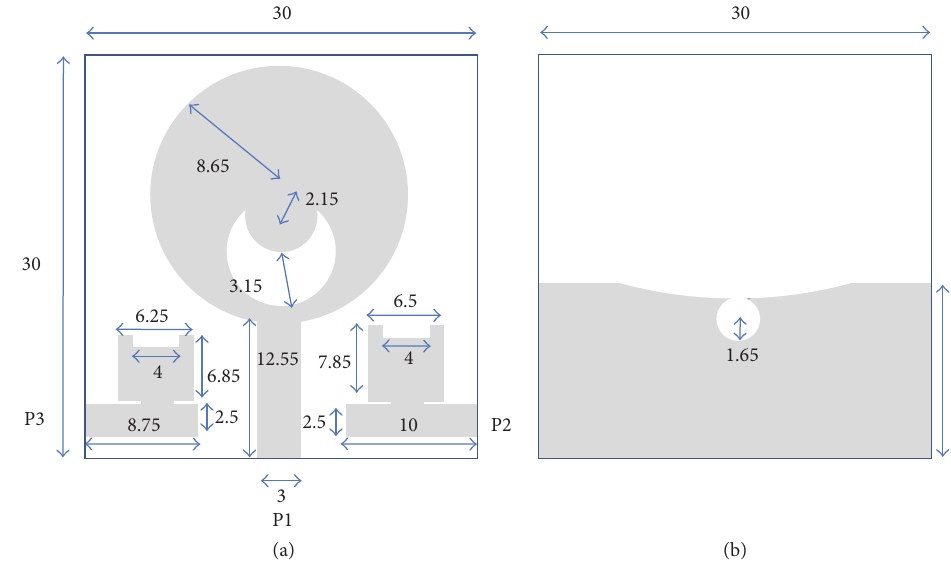
Figure 9: Proposed integrated UWB and NB antennas geometry. (a) Top view. (b) Bottom